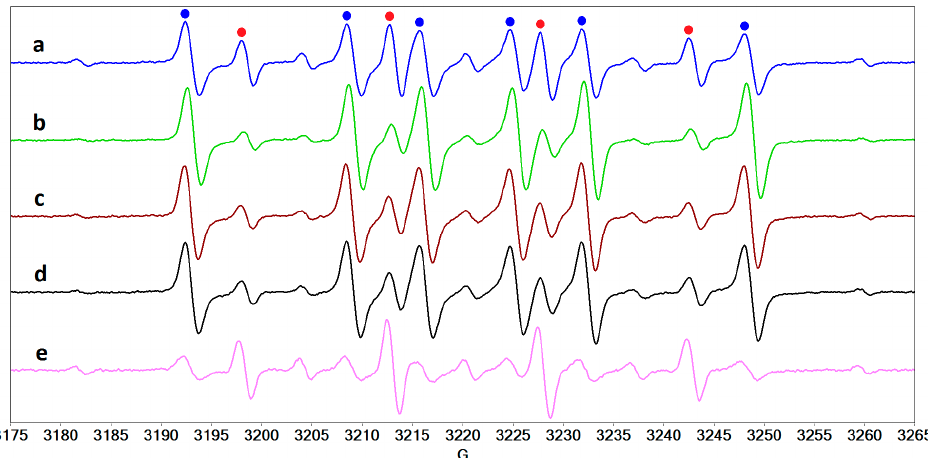
Figure 9. The EPR spectra of DMPO adducts formed after UVA exposure, in the presence of riboflavin, of a solution of ( a ) HSA, ( b ) LF, ( c ) LYZ, and of the mixture of the three proteins in the absence ( d ) and in the presence ( e ) of hyaluronic acid.